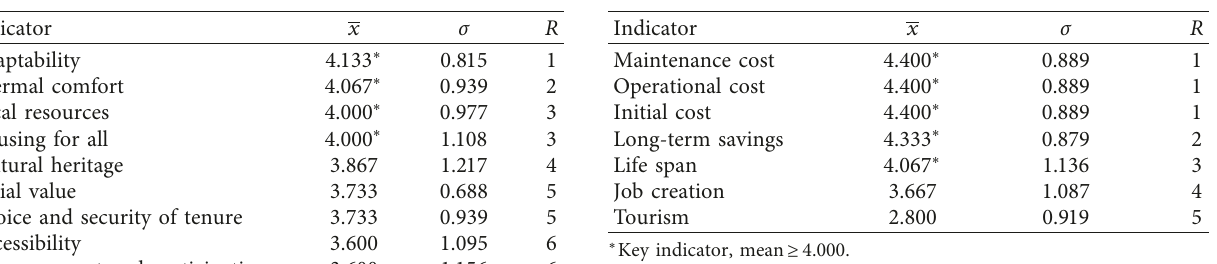
Table 4: Descriptive statistics on social indicators ( n � 45). Table 5: Descriptive statistics on economic indicators ( n �